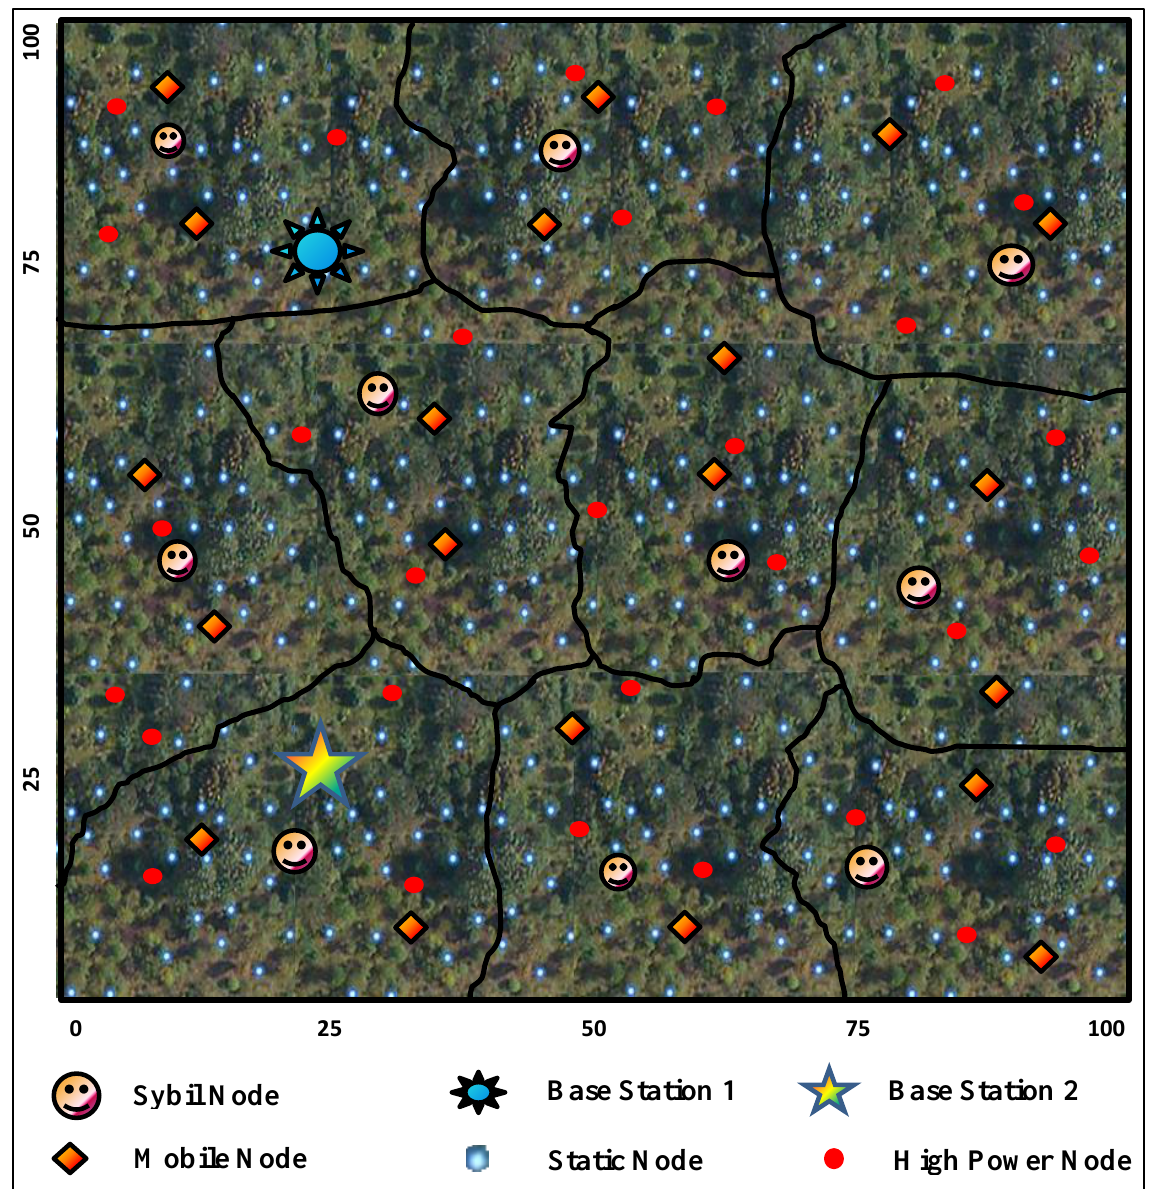
Figure 1. System Model of the Proposed